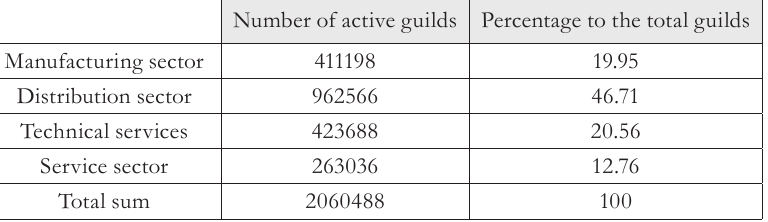
Tab. 1 - Number of guilds in the Iran. (Source: